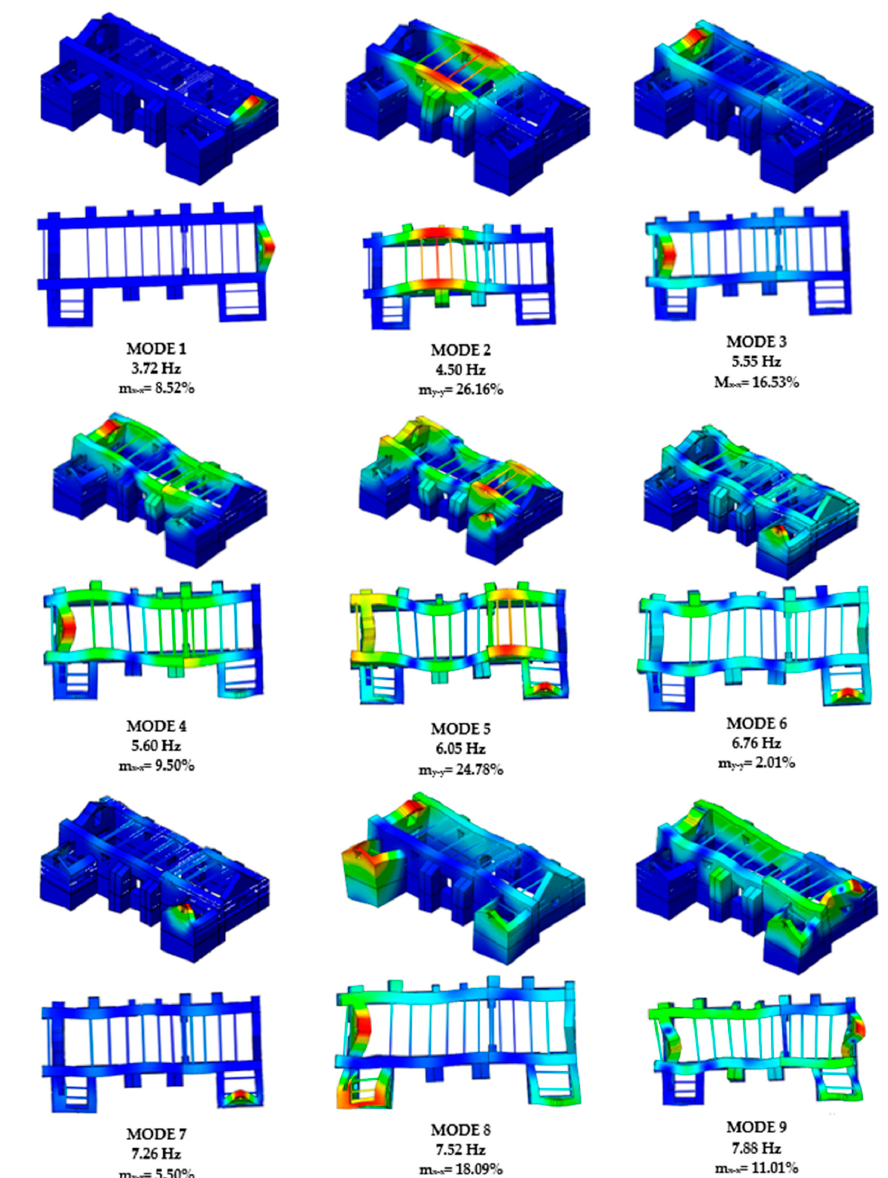
Figure 15. Selected modes from the modal analysis, for the retrofitted model MODEL_1.